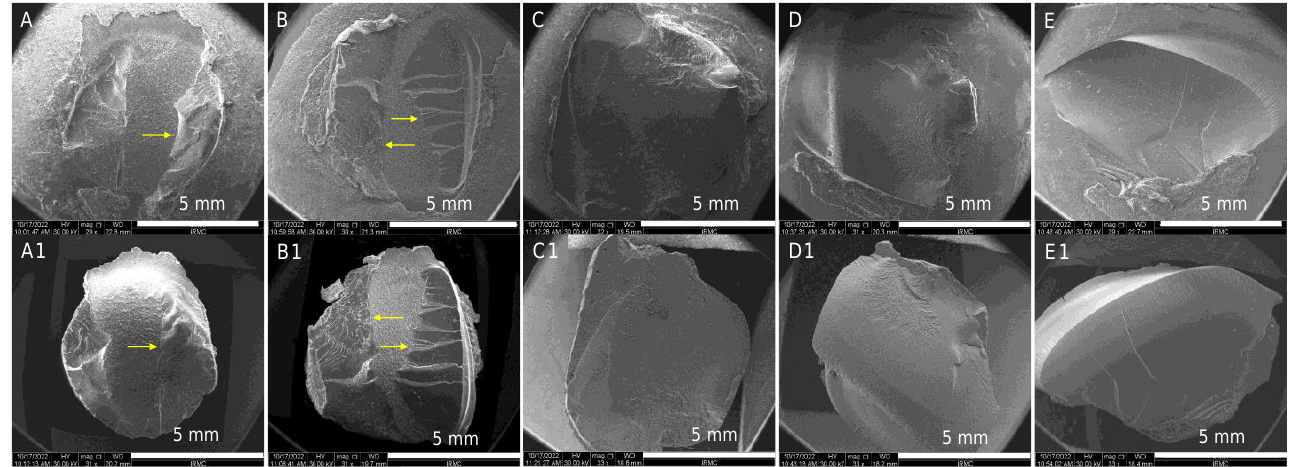
Figure 3. Nature of failure results of 3D-printed resins. Representative SEM images of ( A – E ) denture base resins side and ( A1 – E1 ) repair resin side: ( A , A1 ) IvoCad, ( B , B1 ) NextDent, ( C , C1 ) FormLabs, ( D , D1 ) AvaDent, and ( E , E1 ) ASIGA; arrows indicate mixed failure ( A , B ), and cohesive failure ( C – E ) within the 3D-printed resin surface. SEM magnifications: ×29 – ×33, scale bars = 5 mm.